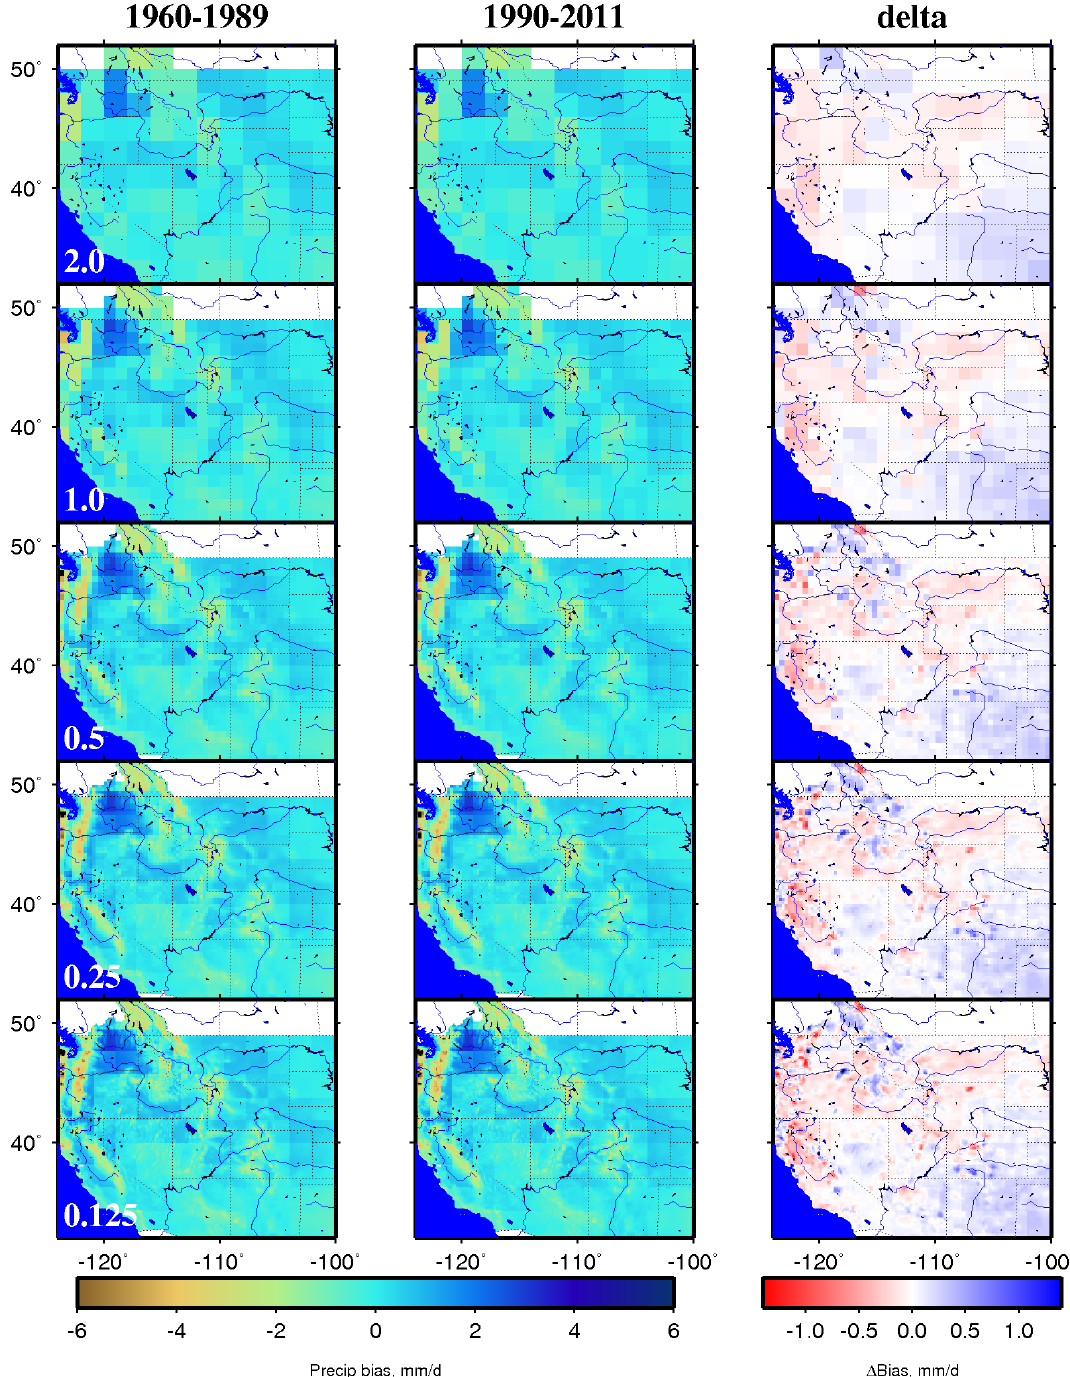
Figure 3. Mean precipitation bias, measured as the difference between reanalysis and observations for the calibration (1960–1989) and vali- dation (1990–2011) periods, and the difference in bias between the two periods. Reanalysis data are interpolated and observations aggregated to the spatial resolution indicated in the left